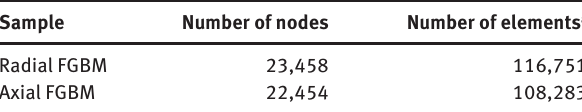
Figure 3: Maximum von Mises stress of cortical and cancellous bones in response the radial FGBM implant ( β =